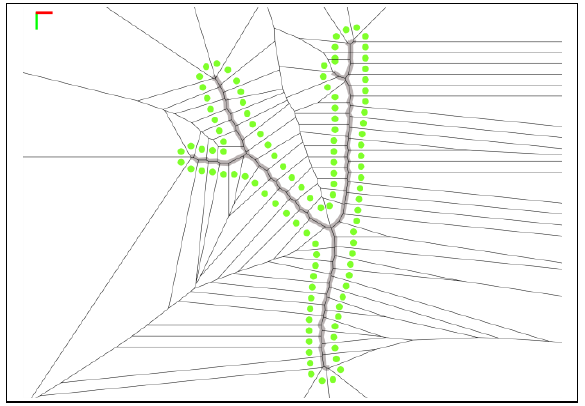
Figure 5. Voronoi Diagram from component boundary (green). The sequence of boundary